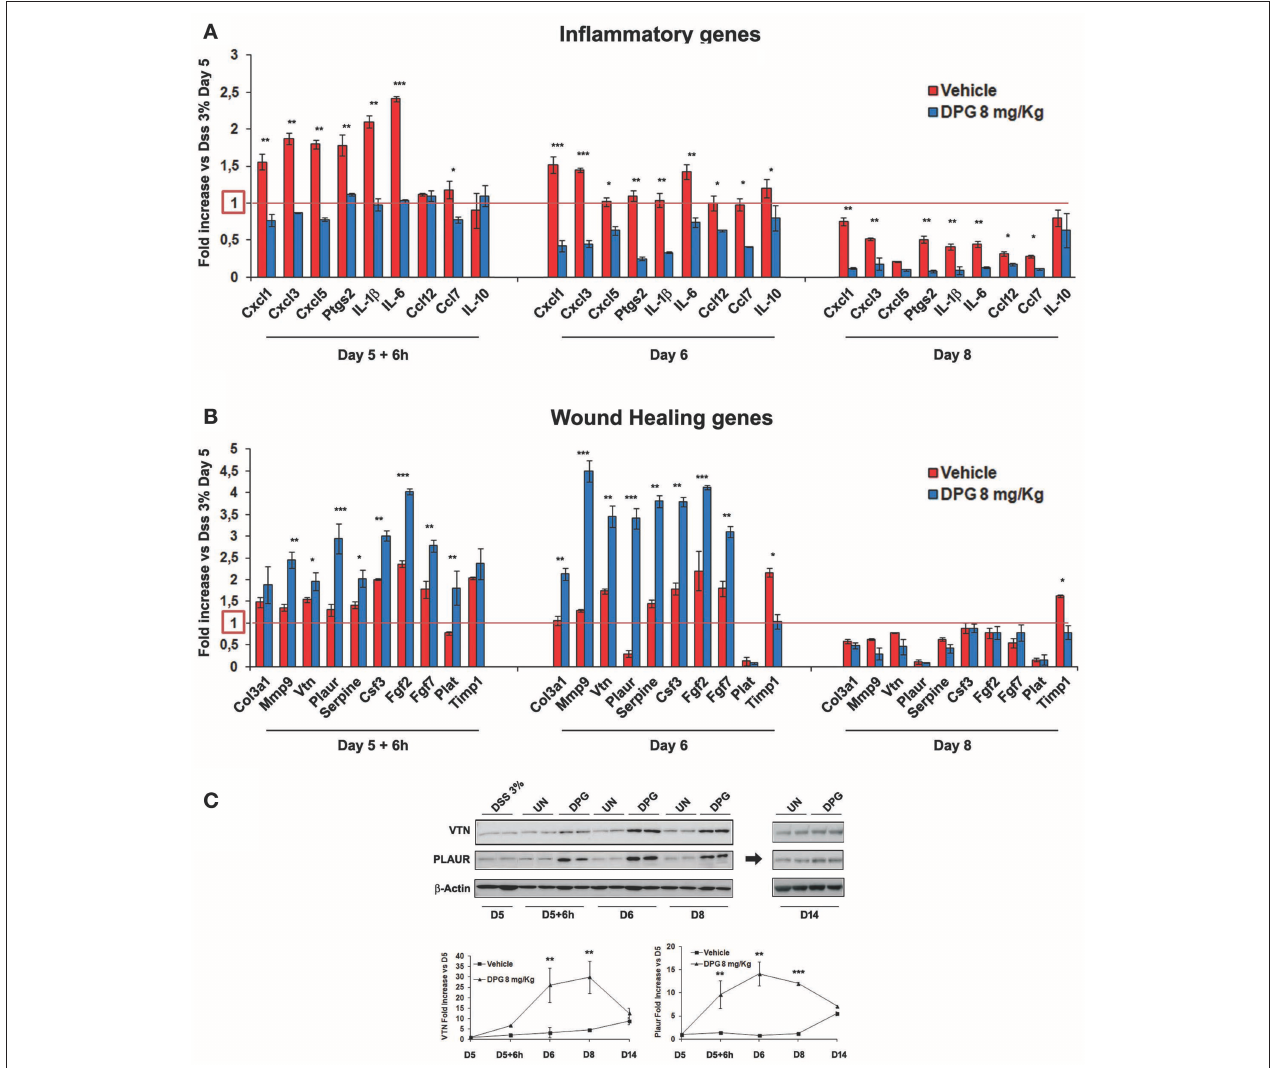
FIGURE 5 | DPG improves mucosal healing in vivo by reducing pro-inflammatory genes and increasing wound healing genes. C57BL/6 mice were treated with DSS for 5 days and then were untreated or treated with DPG (8 mg/kg) for successive 9 days. During remission phase, gene expression of all (A) pro-inflammatory and (B) wound healing genes, previously identified, was analyzed by real-time PCR at the following time point: 5th day + 6h, 6th day, and 8th day. Real-time PCR values are mean + /– St. dev. of 5 animals per experimental group and data represent the target gene expression normalized to the reference gene. The expression level after 5 days of DSS treatment was taken as 1 for each gene. (C) VTN and PLAUR were also analyzed by western blot . Upper panel: western blot; bottom panel: fold increase vs. day 5th calculated using optical densitometry. Five animals per experimental group were used. Statistical analysis: Kruskal-Wallis Test with Dunn’s